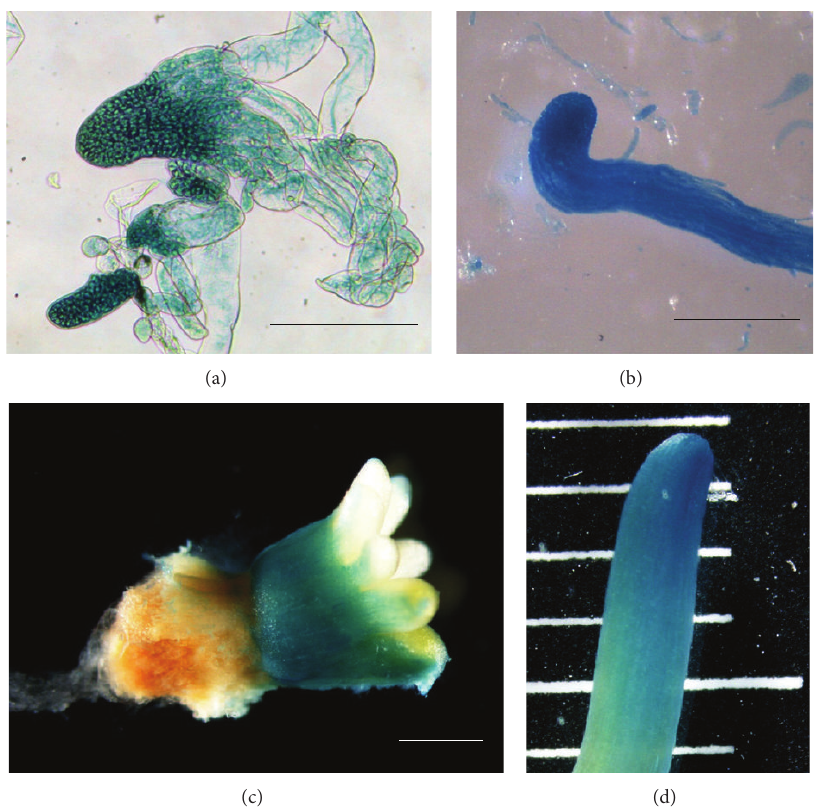
Figure 3: GUS activity after 16 h incubation in GUS solution. Embryos in different stages after 15 (stage 1 embryo; (a)), 45 (stage 2 embryo; (b)), and 90 days (stage 3 embryo; (c)) on maturation medium. Young needle (d). Bar and divisions =